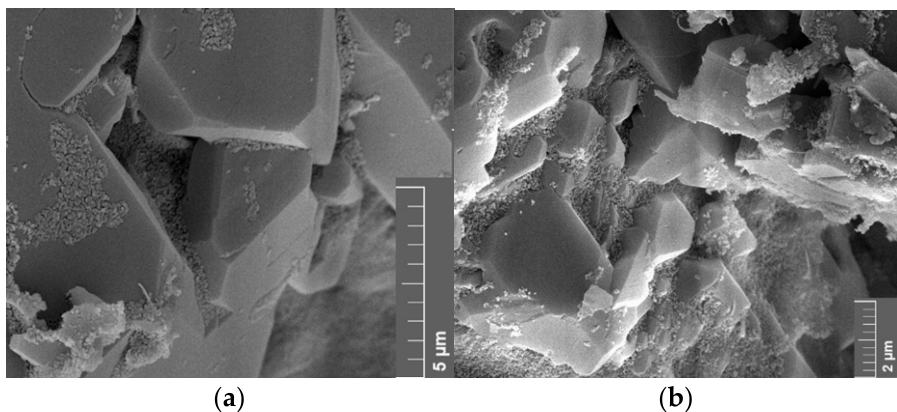
Figure 20. Scanning electron microscope (SEM) images measured for the core material used in this work. This image shows a comparison between adsorption of NF A to Berea in formation water ( a ) compared to TW ( b ). Surfaces in the FW sample were coated slightly more with nanomaterials. (left: Vacuum saturation of 1 wt% NF A in FW, Berea; right: vacuum saturation of 1 wt% NF A in TW, Berea).